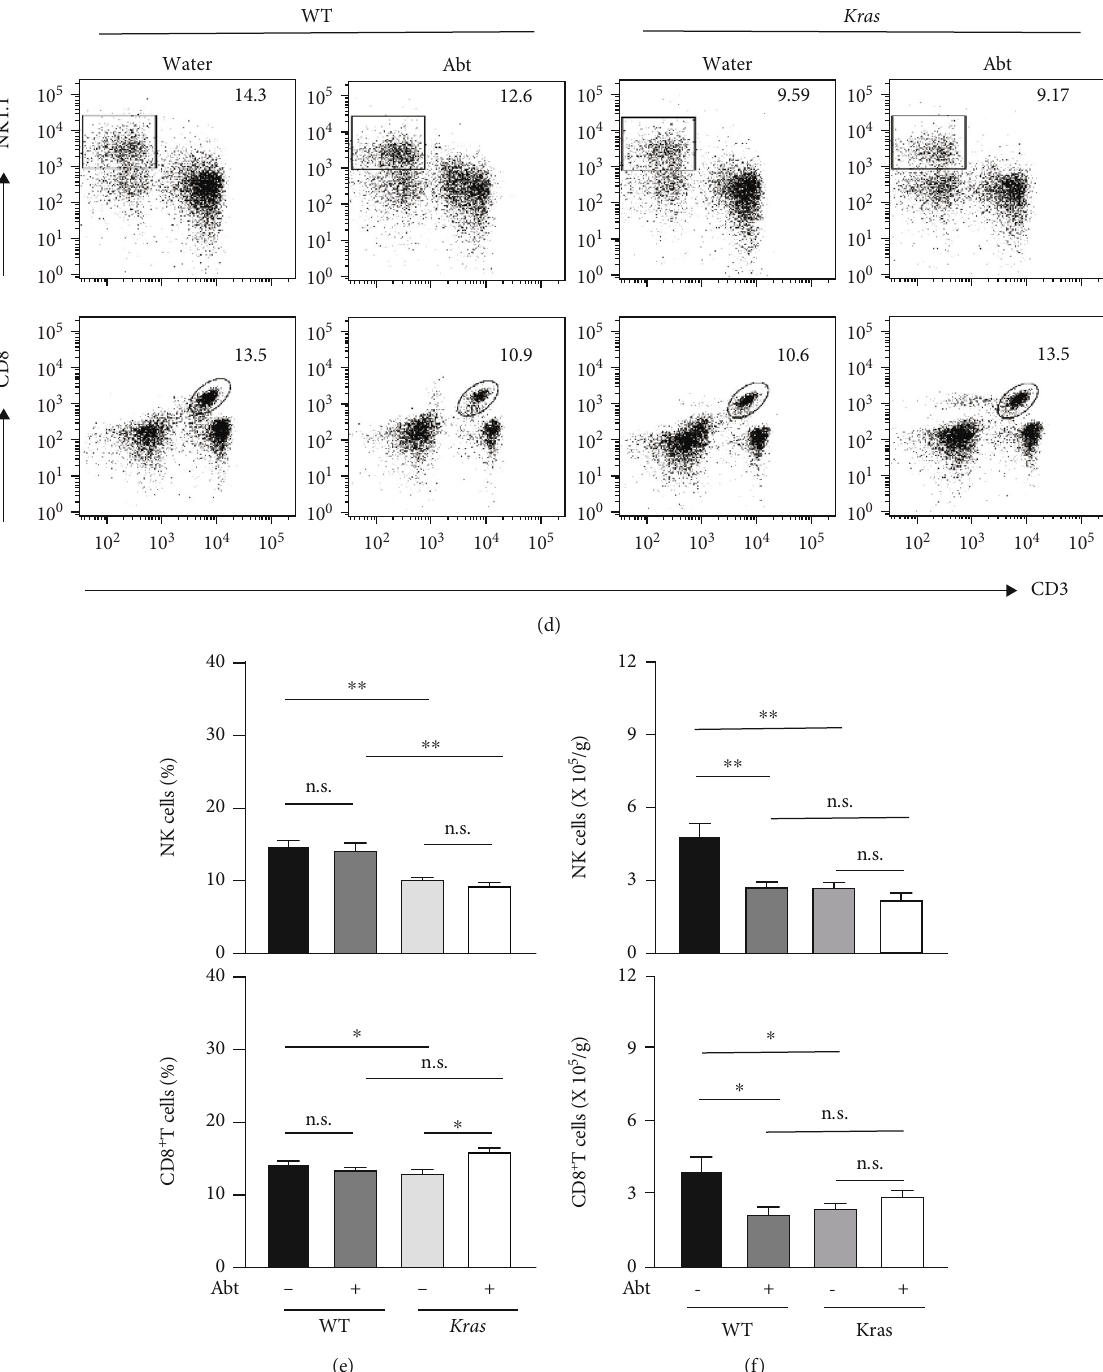
Figure 2: The e ff ects of the commensal microbiota on the percentage and number of NK cells and CD8 + T cells in di ff erent stages of lung cancer. (a – c) Representative FCM plots (a) and quanti fi cation of the percentages (b) and numbers (c) of lung CD45 + CD3 - NK1.1 + NK cells and CD45 + CD3 + CD8 + cells at stage 1 of cancer. (d – f) Representative dot plots (d) and quanti fi cations of the percentages (e) and numbers (f) of lung NK and CD8 + T cells at stage 3 cancer, n = 5 − 6 . Data are presented as mean ± SEM . ∗ p < 0 : 05 and ∗∗ p < 0 : 01 . n.s.: not signi fi